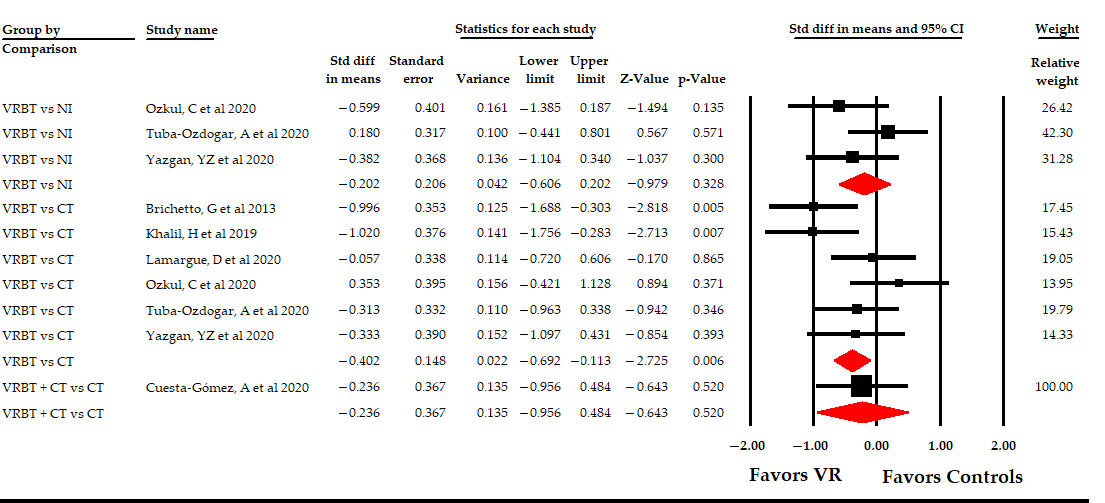
Figure 3. Subgroup Analysis of the Effect of Virtual Reality on Fatigue According to Specific Comparisons.